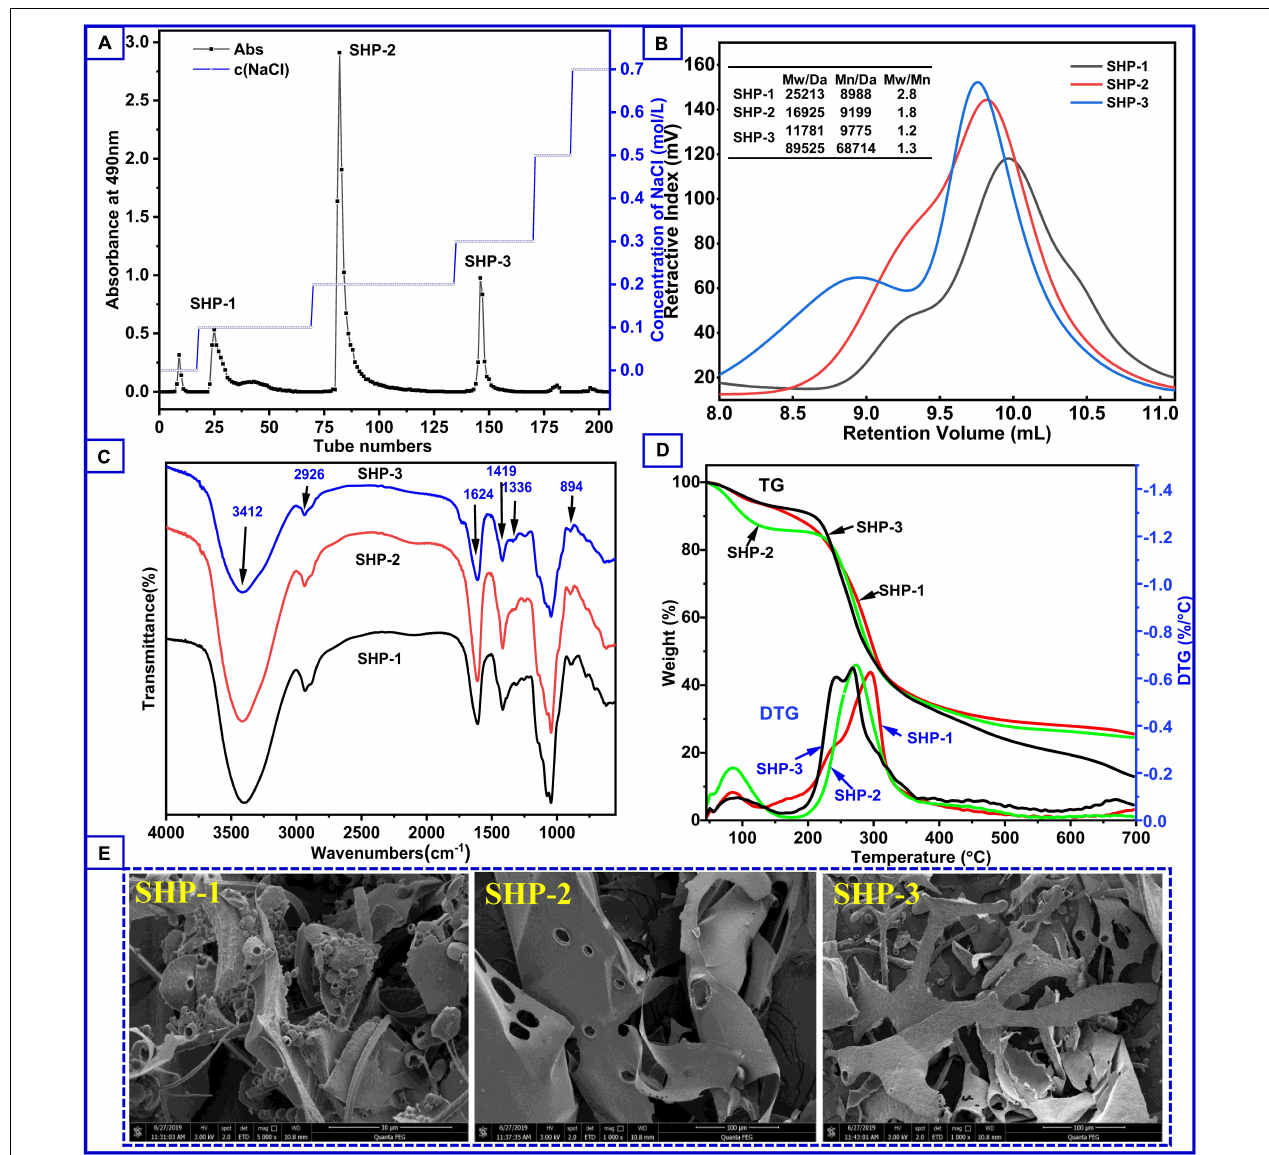
FIGURE 1 | (A) Content of polysaccharide fractions obtained by elution at different salt concentrations during column chromatography. (B) Molecular weight distribution of polysaccharide samples. (C) Fourier transform infrared spectroscopy of polysaccharide samples. (D) Thermogravimetry curves (left axis) and derivative thermogravimetry curves (right axis) of SHP-1, SHP-2, and SHP-3. (E) The scanning electron microscope of the